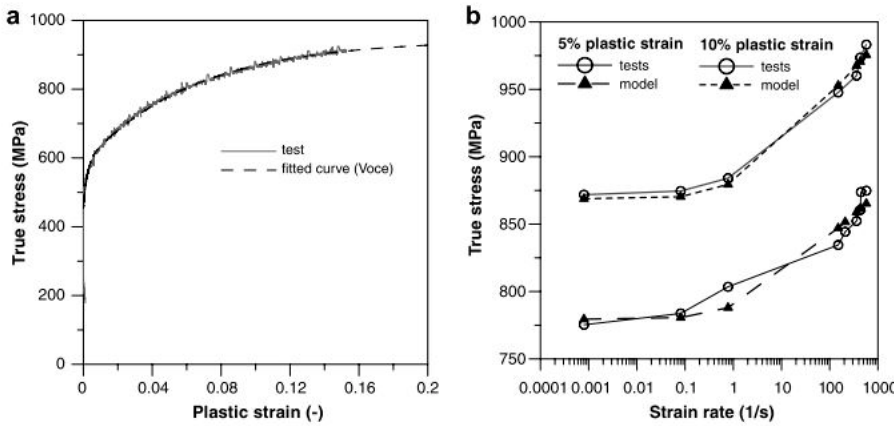
Figure 40. Comparison of calculated and experimental curves for DP800 steel for ( a ) strain hardening and ( b ) strain-rate hardening [162] .